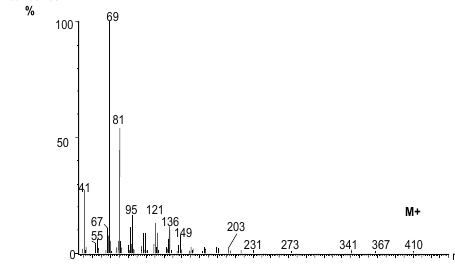
Fig. 2b. GC-MS spectrum of squalene.